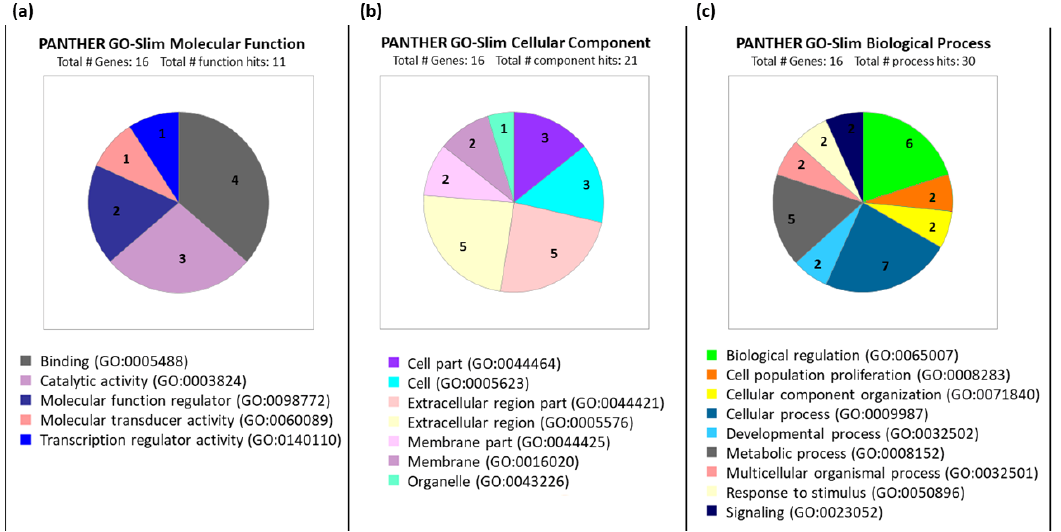
Figure 2. PANTHER classification of selected genes. PANTHER gene ontology classification of 16 selected genes based on ( a ) molecular function, ( b ) cellular component of expression, and ( c ) involvement in biological processes. Large-scale gene function analysis protocol for PANTHER Version 14 classification system used for this analysis [30,31].